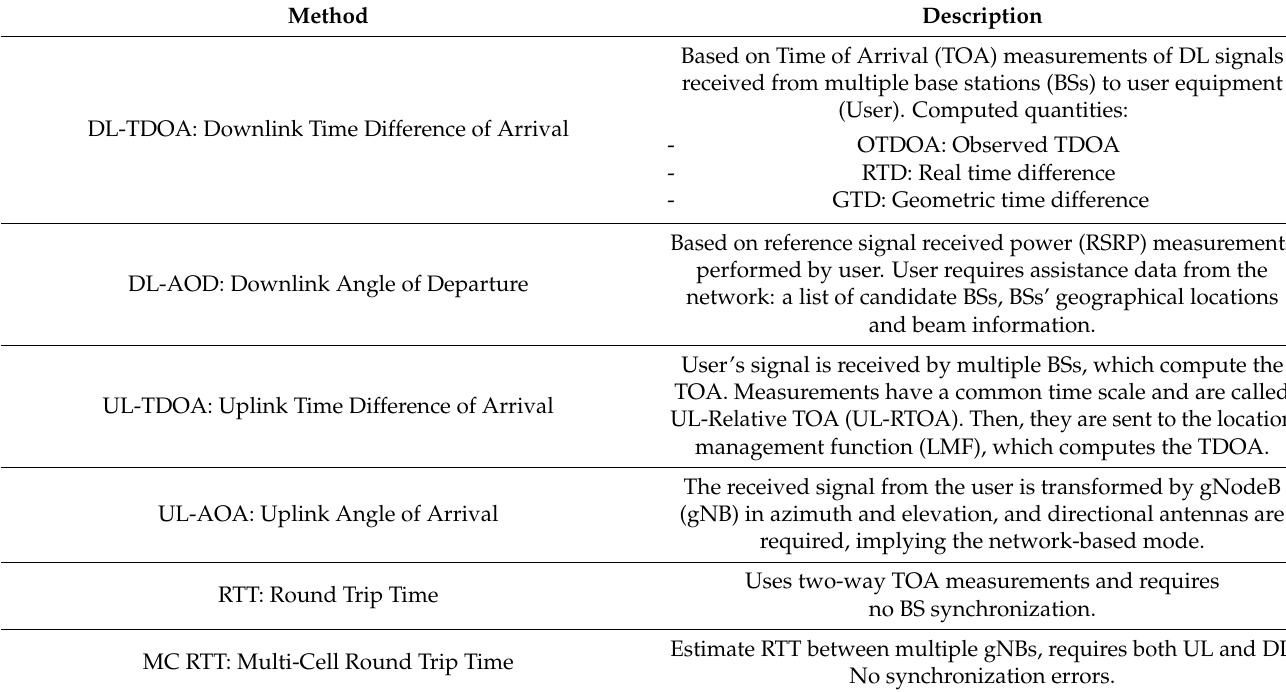
Table 2. Available 5G positioning methods [8,9].